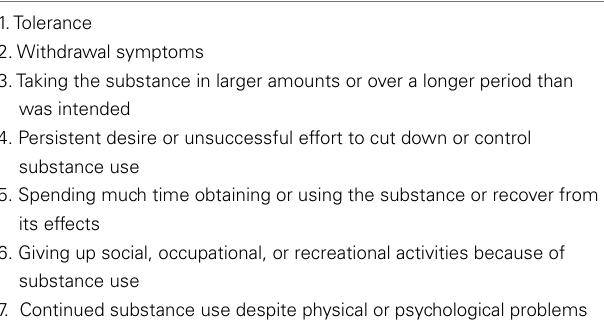
Table 1 | Diagnostic criteria for substance dependence according to the DSM-IV.